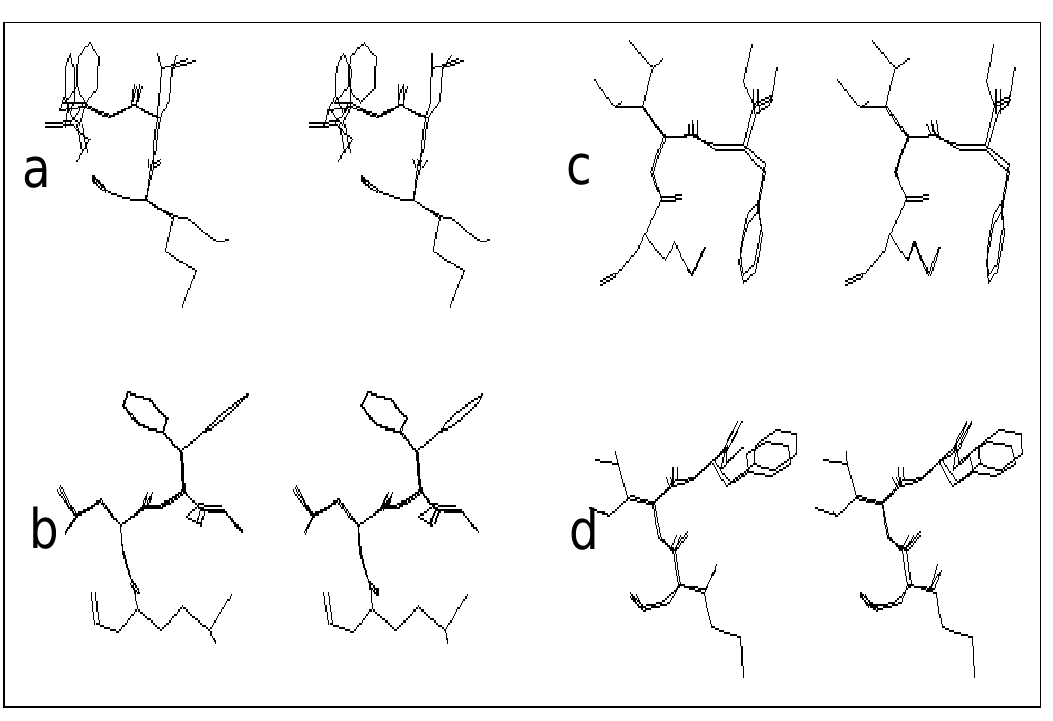
Figure 2. Stereoscopic superposition view of conformers of different classes obtained in the case of